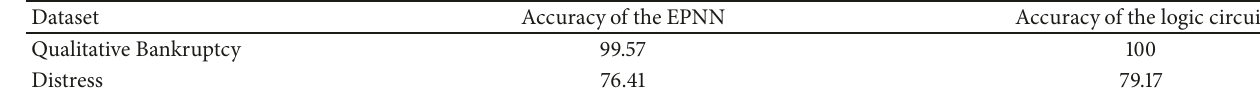
Table 16: Verification of the logic